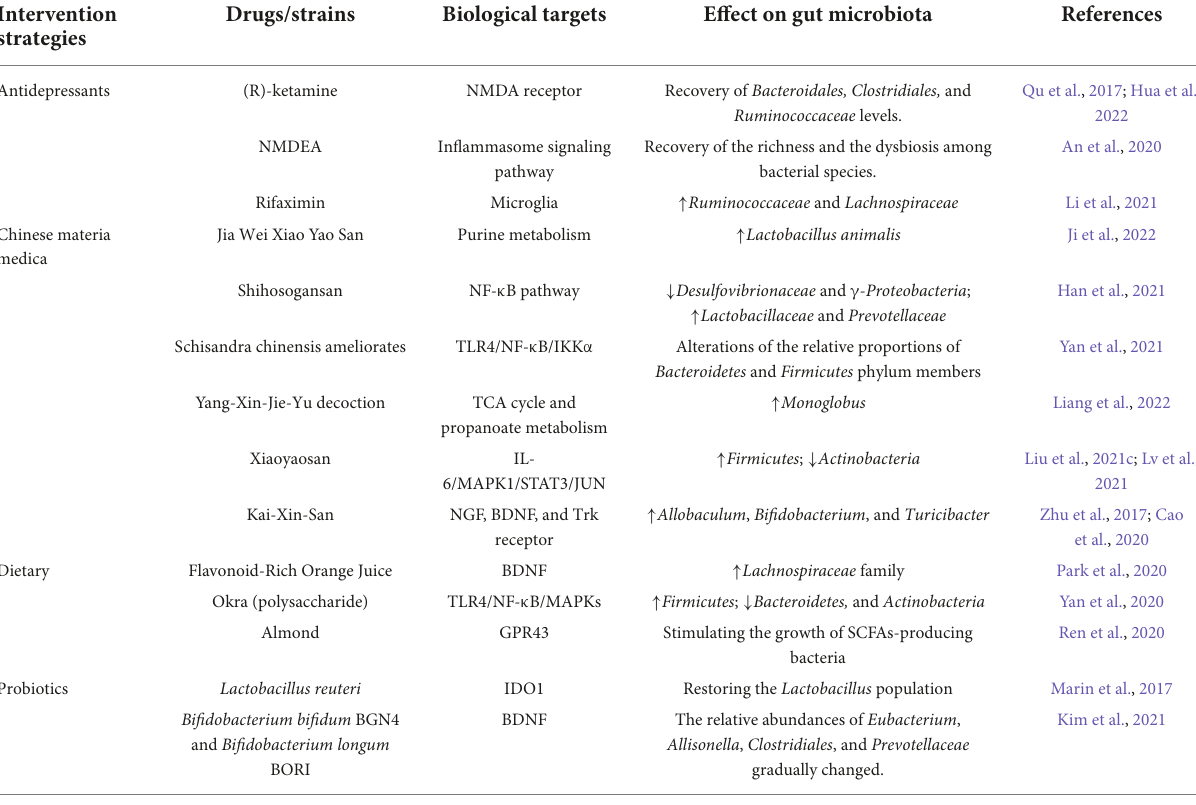
TABLE 2 Different antidepressant therapeutic approaches and their biological